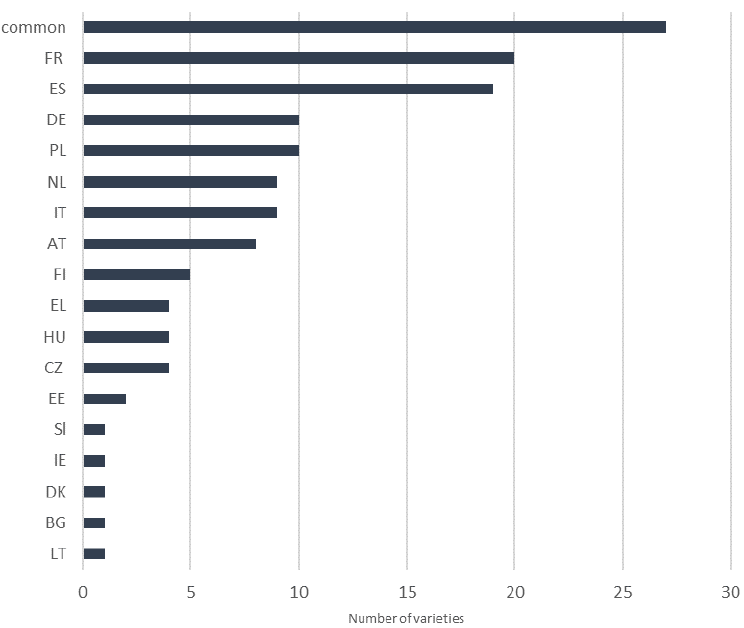
Figure 10. Number of field bean varieties in EU countries [44]. Tendencies of new variety registrations are similar to those of the field pea (Figure 11). There are some old varieties on the list and the highest number of varieties was found in 2019.